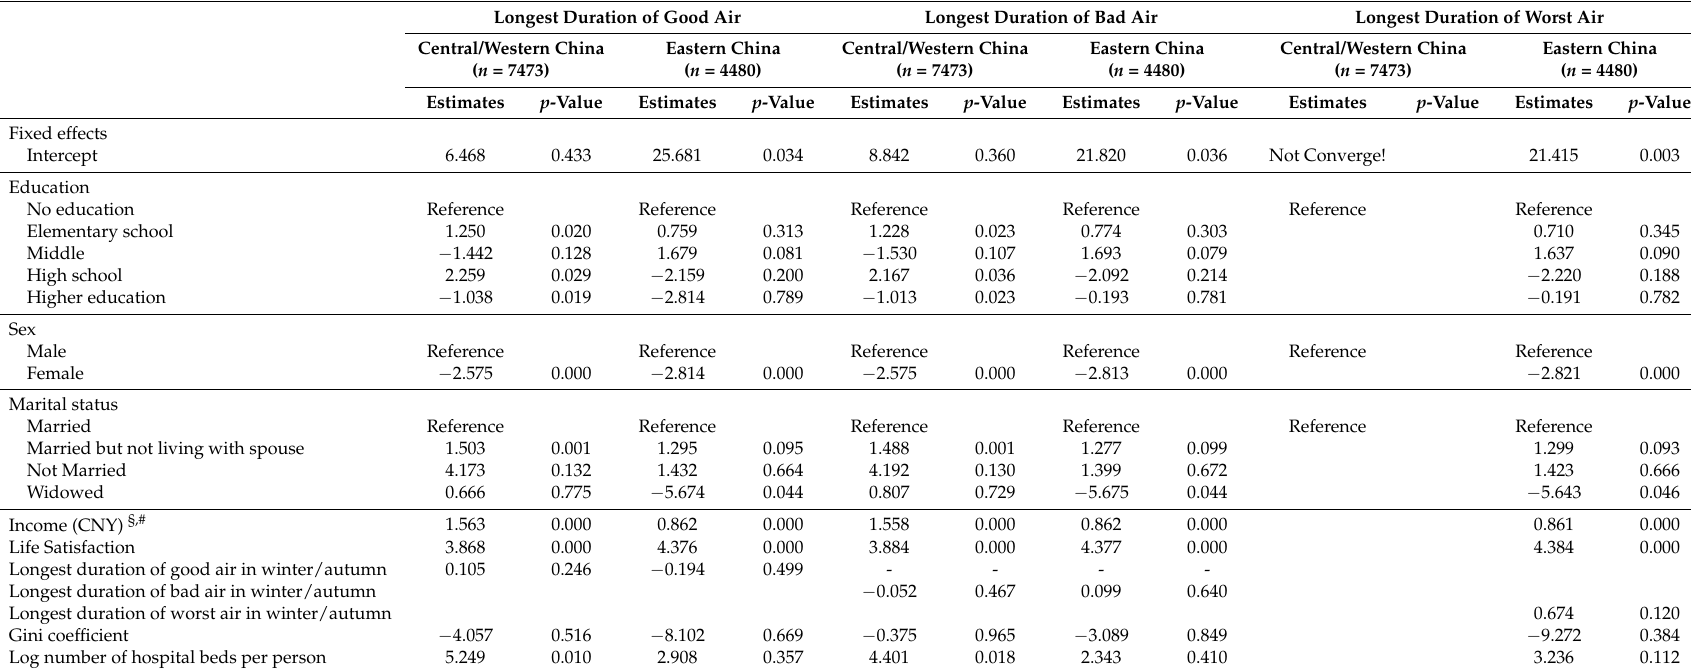
Eastern China ( n = 4480)